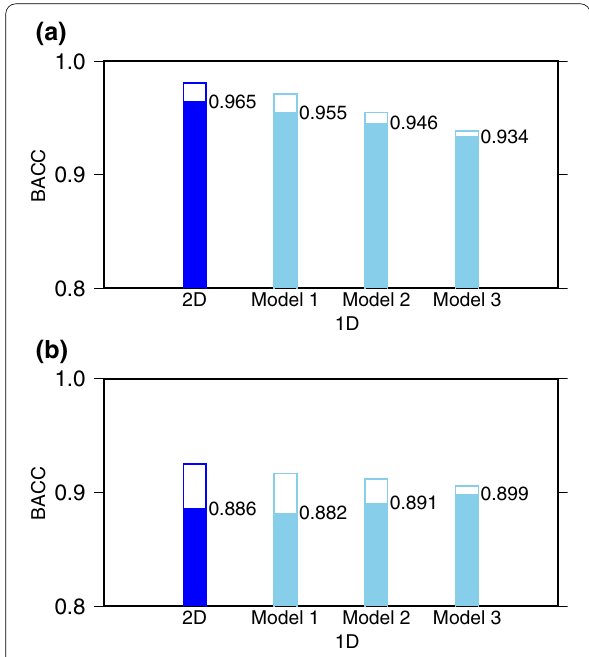
Fig. 2 Balanced accuracy (BACC) scores after training the 1D and 2D CNN models. a Nankai and b Sakurajima datasets. Open bars show BACC scores when applied to the validation dataset and filled bars with corresponding values reported show BACC scores when applied to the test